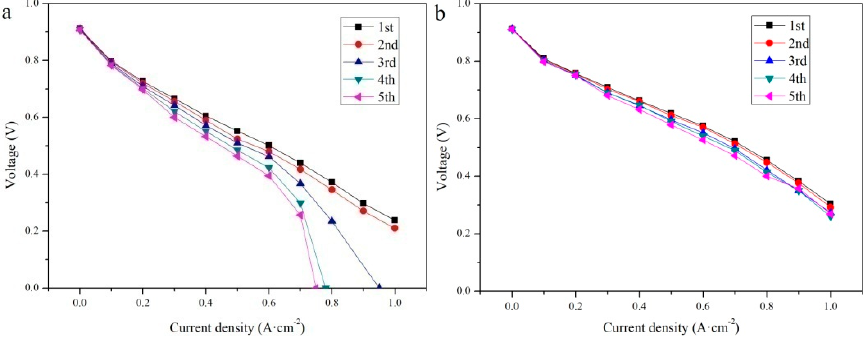
Figure 13. Performances of the cells: ( a ) Bare 304 SS as the bipolar plate and ( b ) 304 SS with vertical CNTs as the bipolar plate.